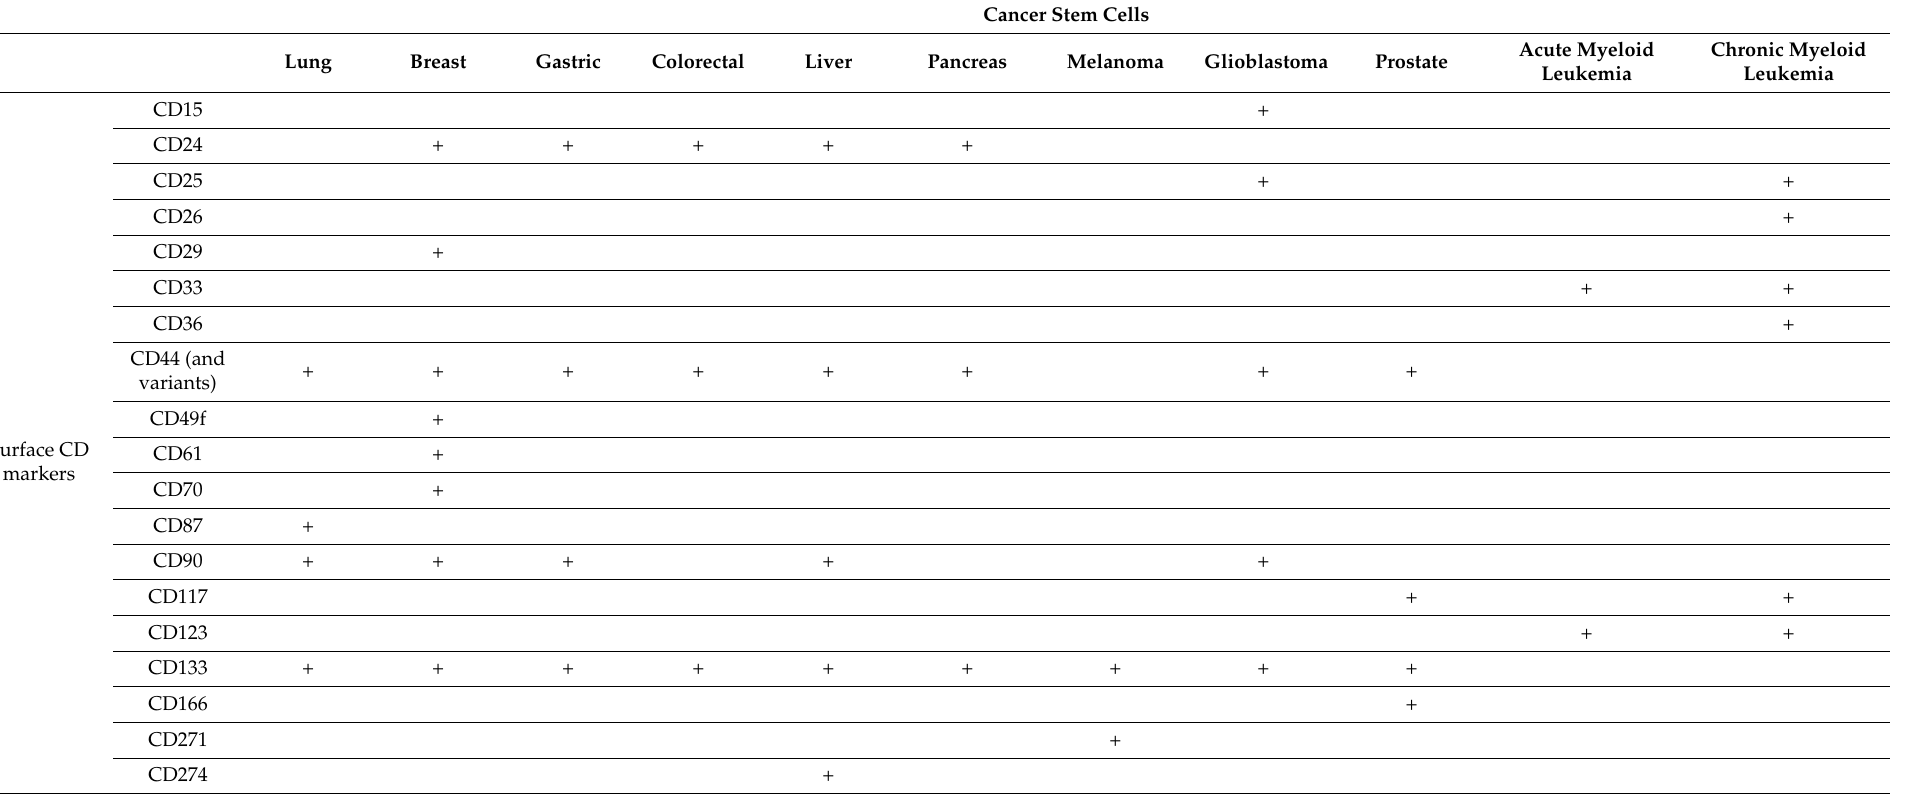
Table 1. In the most commonly investigated cancers, CSC-related markers have been revealed. It is important to note that several of these markers may also be expressed by healthy stem cells and normal tissue cells (for more information on this topic, see references [3–6]). EpCAM: Epithelial cell adhesion molecule; CXCR4: C-X-C chemokine receptor type 4; Lgr5: Leucine-rich repeat-containing G-protein coupled receptor 5; ProC-R: Protein C receptor; LINGO2: Leucine rich